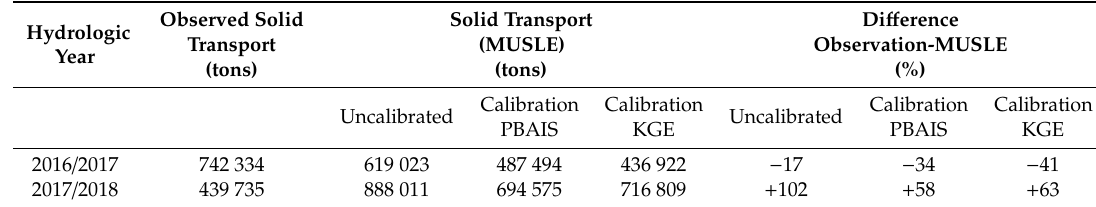
Table 14. Results of the MUSLE model at Aguibat Zear on the Bouregreg and a comparison with observations.